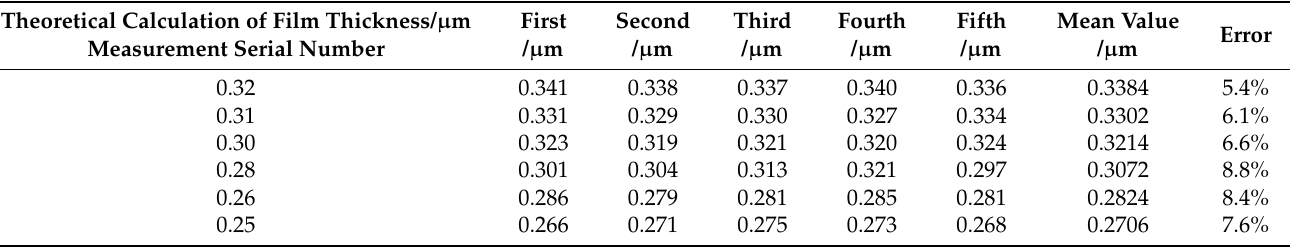
Table 5. Comparison of experimental measurement and theoretical calculation results under different load